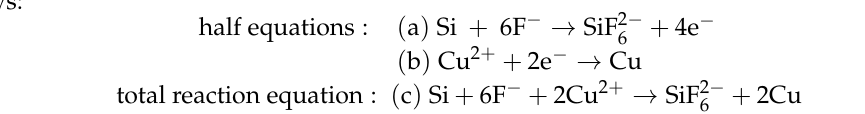
Figure 3. Atomic force microscopy (AFM) images of Cu surface morphology of the ( a ) control; ( b ) CDT 60 s; ( c ) CDT 75 s; and ( d ) CDT 90 s samples. A schematic model is illustrated in Figure 4 to describe the mechanism of the ReRAM fabricated using the Cu-CDT method. Figure 4a,b correspond to the samples obtained using a long (CDT 90 s) and short displacement time (CDT 60 s), respectively, in the Forming operation; the insets present RMS: 4.115 nm